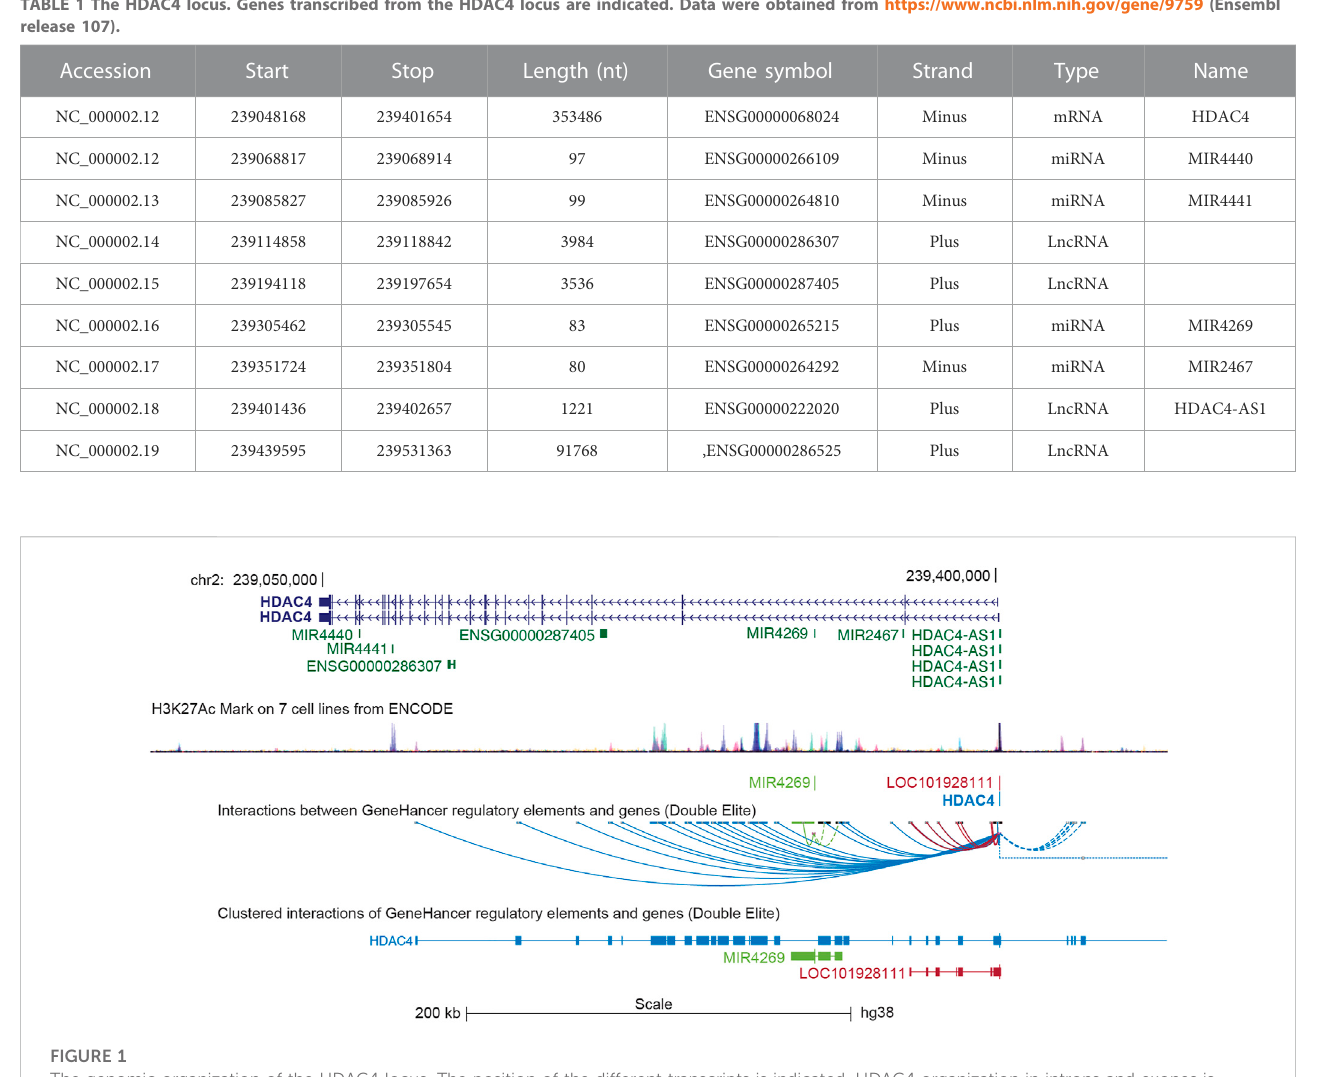
The genomic organization of the HDAC4 locus. The position of the different transcripts is indicated. HDAC4 organization in introns and exones is highlighted. The H3K27ac marks obtained from 7 cell lines of the encoded project are indicated to underline the regulative regions. LOC101928111 corresponds to HDAC4-AS1. Data were retrieved from https://genome.ucsc.edu/ UCSC Genome Browser on Human (GRCh38/hg38). The GeneHancer tool was selected to visualize putative enhancers and DNA